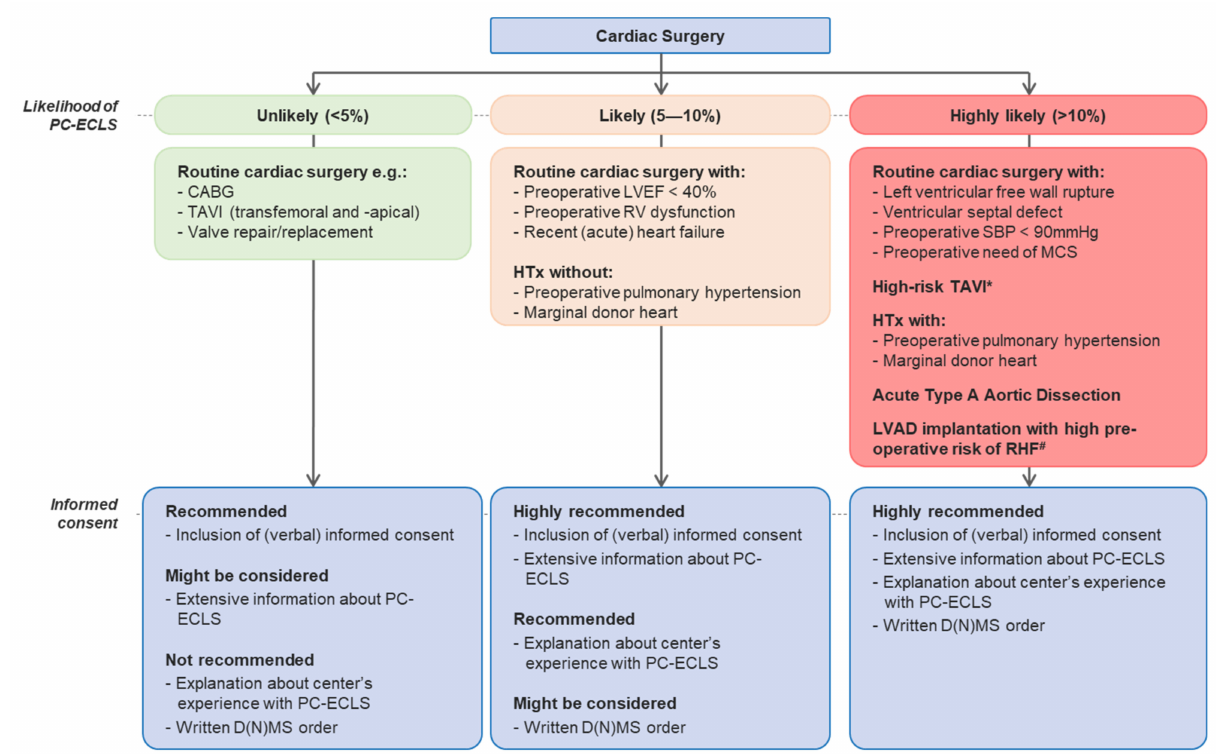
Figure 1. Recommendations regarding informed consent for PC-ECLS. Abbreviations: CABG: coronary artery bypass